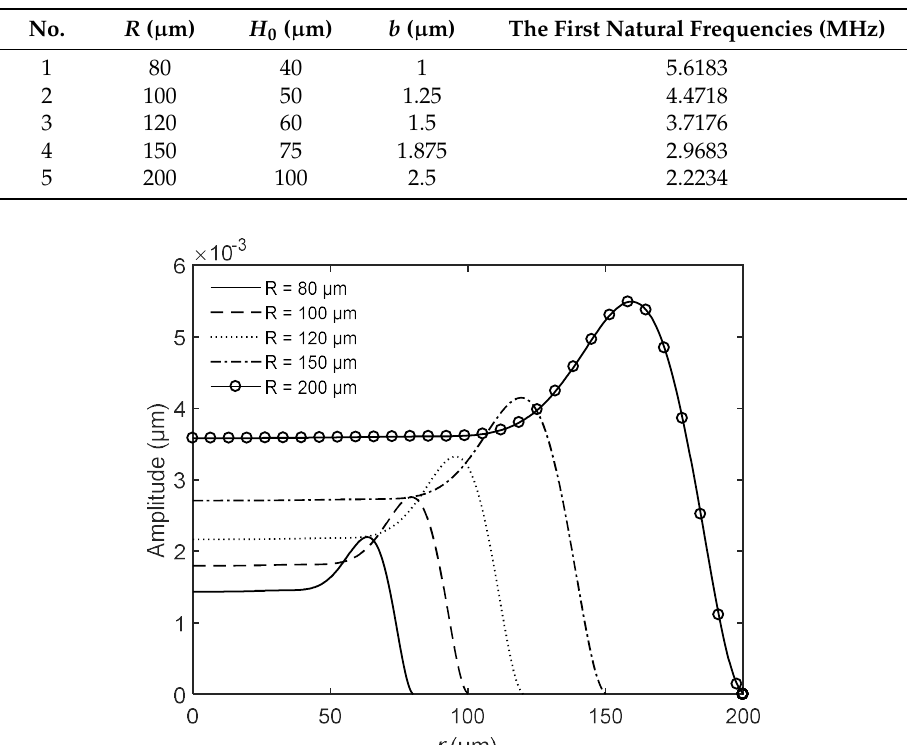
Table 6. The first natural frequencies of the bionic structures of di ff erent scales with constant ratio R : H 0 : b = 80:40:1.